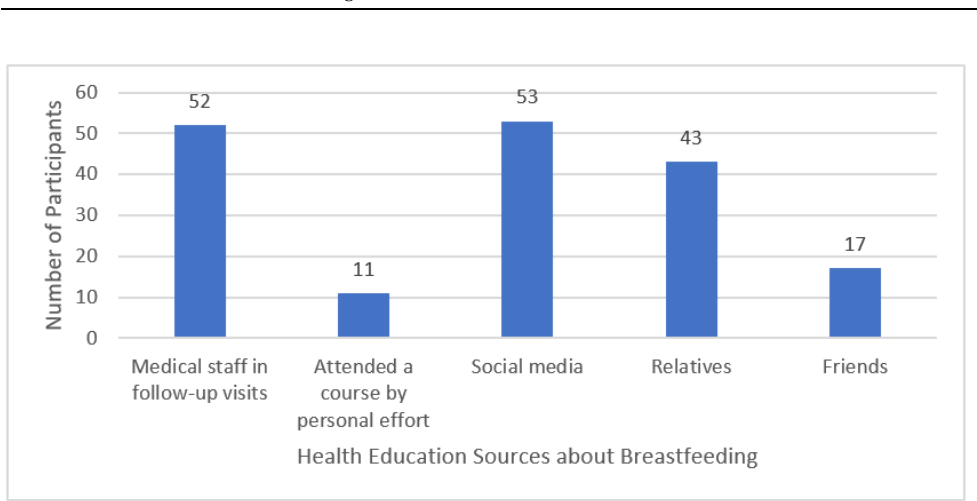
Figure 1. Health education sources about breastfeeding of the participants.